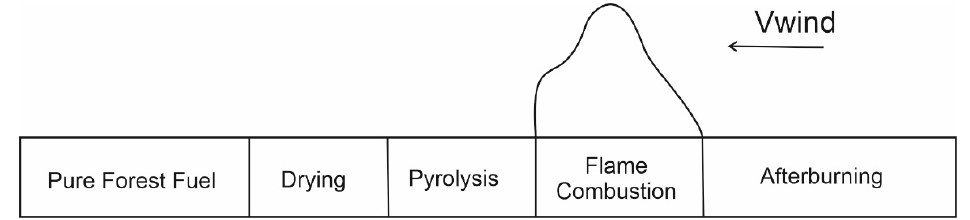
Figure 2. Scheme of the forest fire stages.